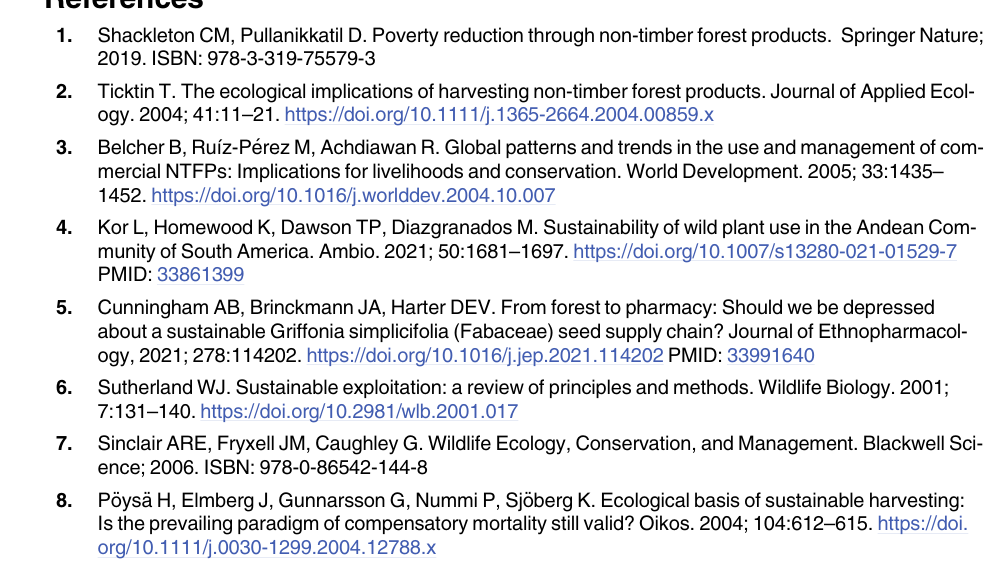
S1 Table. Size and fate of Forsteronia glabrescens Mu¨ll.Arg ramets experimentally managed in the S ã o Pedro Municipal Reserve, Porto Alegre, South Brazil,